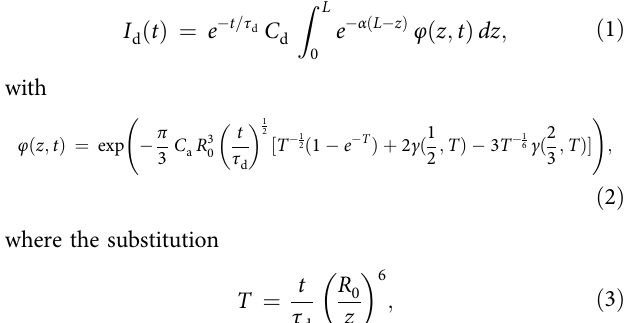
MAPbI 3 :quartz samples as black lines superimposed on the experimental data (orange) in the left column, with errors (grey shaded areas) deduced from measurement uncertainties. We are